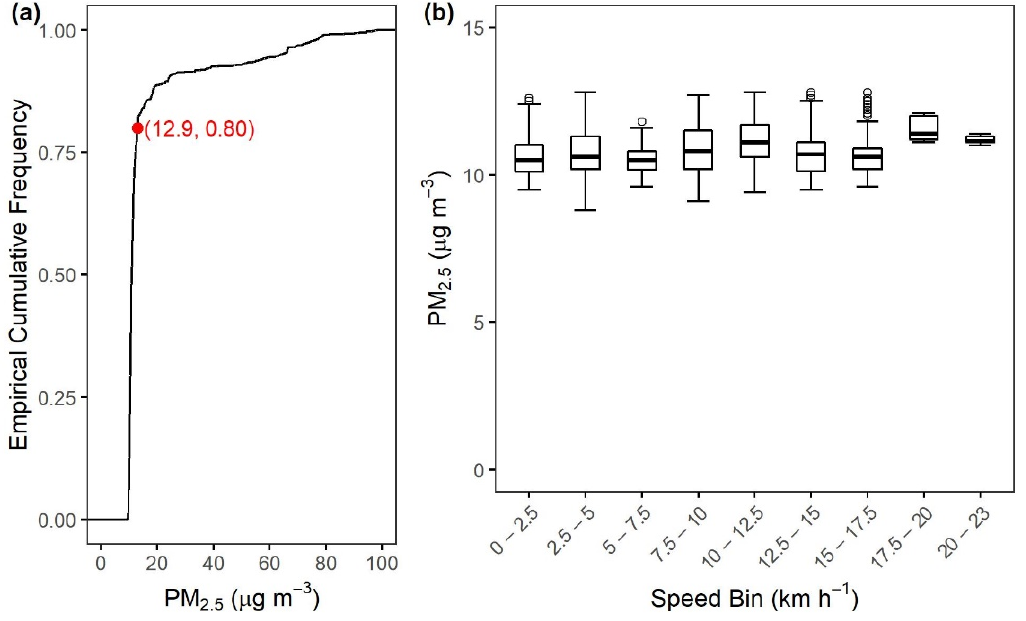
Figure 11. PM 2.5 concentrations measured by one Smart-P (ID: 508) during the Nanjing bicycle test: ( a ) empirical cumulative distribution and ( b ) relationship between the bottom 80% PM 2.5 concentrations and cycling speed.